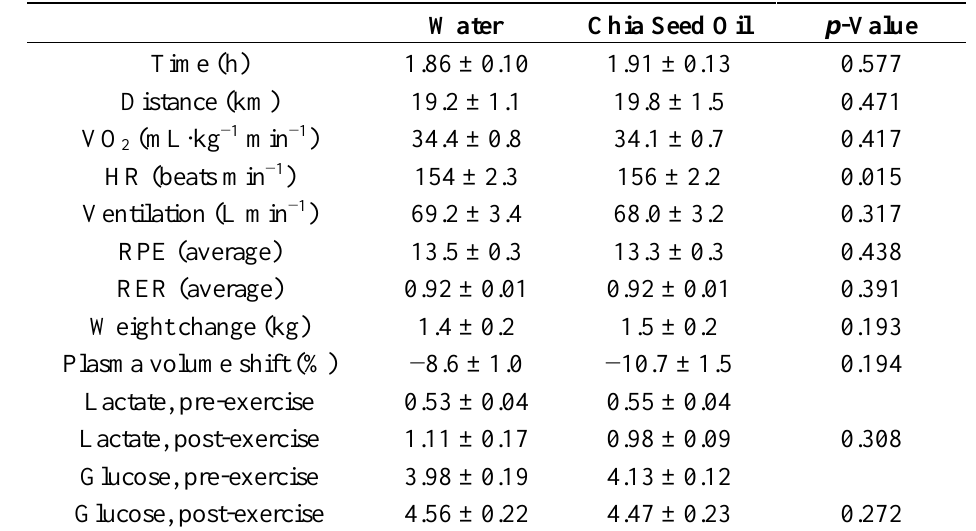
Table 2. Metabolic and performance data during the run-to-exhaustion trials under water and chia seed oil conditions in trained runners ( n = 24) (mean ± SE) *